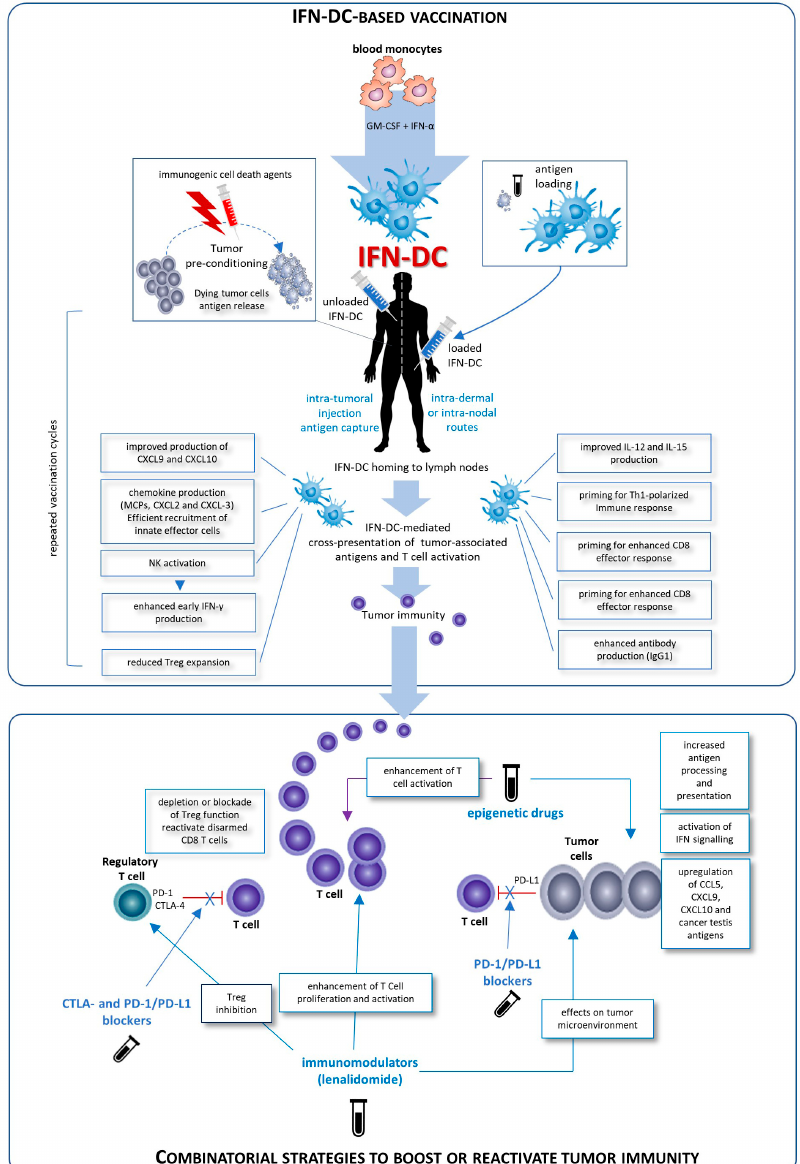
Figure 1. Possible clinical exploitation of IFN-DC in cancer vaccination. Patients undergo leukapheresis to collect PBMC and purify blood monocytes necessary for IFN-DC generation. Large numbers of partially mature IFN-DC can be easily obtained at one-time-point from purified peripheral blood monocytes cultured in the presence IFN- α and GM-CSF, loaded or not with tumor antigens, and cryopreserved in ready-for-use aliquots for the programmed cycles of treatment. On the left is depicted the prototypical intratumoral vaccination strategy based on the concept of tumor preconditioning with immunogenic cell death agents followed by unloaded IFN-DC. The intratumoral injections are guided by ultrasound and performed by a radiologist to ensure correct administration. In the right of the figure, the therapeutic vaccination strategy is shown. IFN are loaded in vitro with selected formulation of tumor antigens and administered intradermally, in close vicinity to axillary and inguinal lymph nodes or directly administered into a healthy lymph node. In both strategies the treatment cycles are repeated at two-week intervals. IFN-DC are characterized by the capacity to release a unique array of cytokines and chemokines known to favor Th1 type response and to powerfully stimulate cellular CD8 + T cell immune responses as well as to promote IgG1 isotype antibodies response